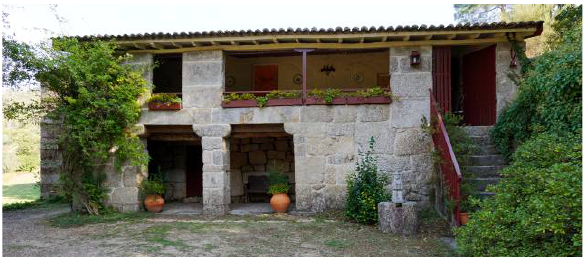
Figure 3. View of the west façade.